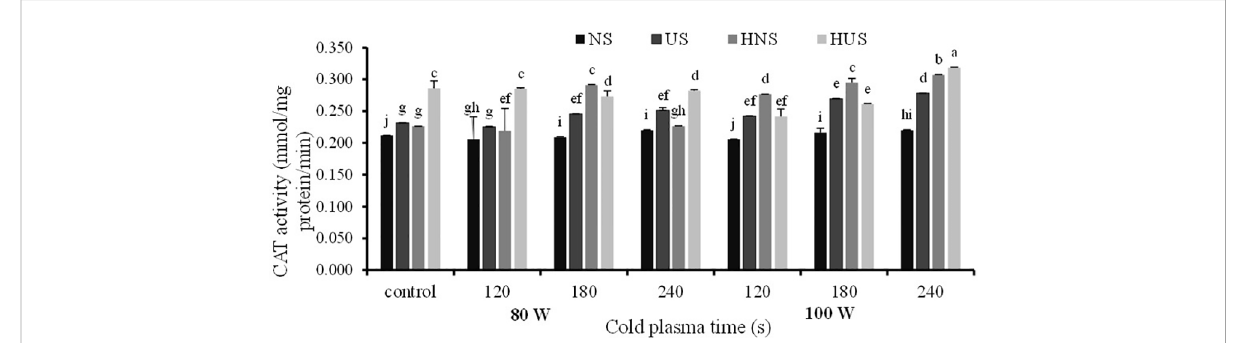
FIGURE 10 The effect of power and exposure time of cold plasma and seed situation on CAT activity of S. leriifolia germinated seeds. Normal seeds (NS), Uncovered seeds (US), Hydro-primed normal seeds (HNS) and Hydro-primed uncovered seeds (HUS). Values represent mean S.E. Different letters indicate signi fi cant differences at the 1% level according to the LSD